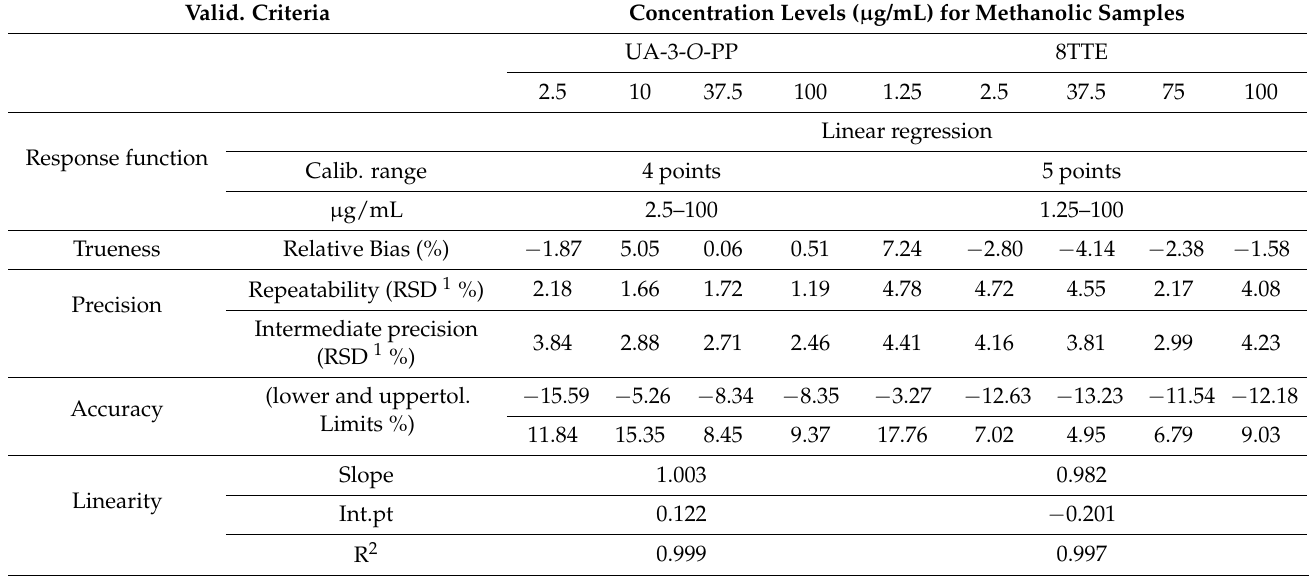
Table 1. Validation results obtained for the quantification method of UA-3- O -PP and 8TTE in MeOH. Valid. Criteria